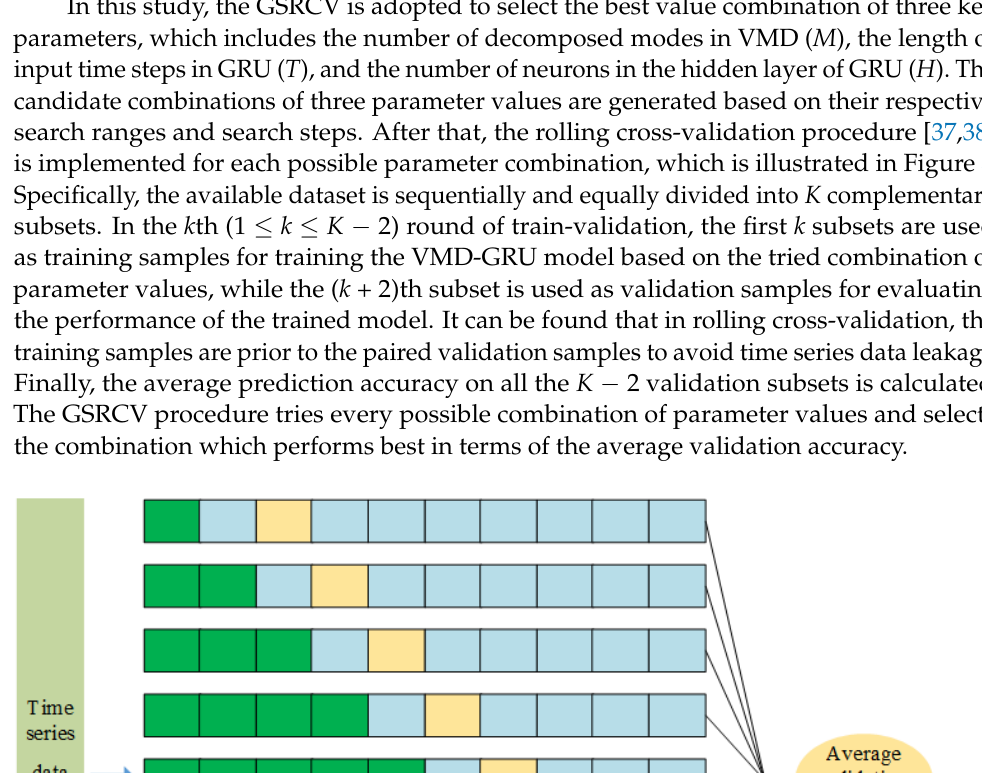
Figure 2. Inner structure of GRU cell [23].